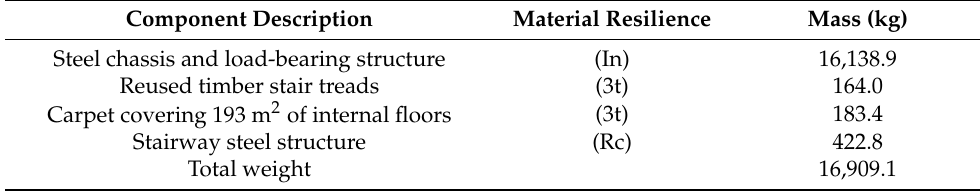
Figure 6. ( a ) The starting point for the project was the reused structural steel frames. ( b ) The steel frames reimagined in Framecad software. Table 2. Weight of materials that were reintroduced into the L3